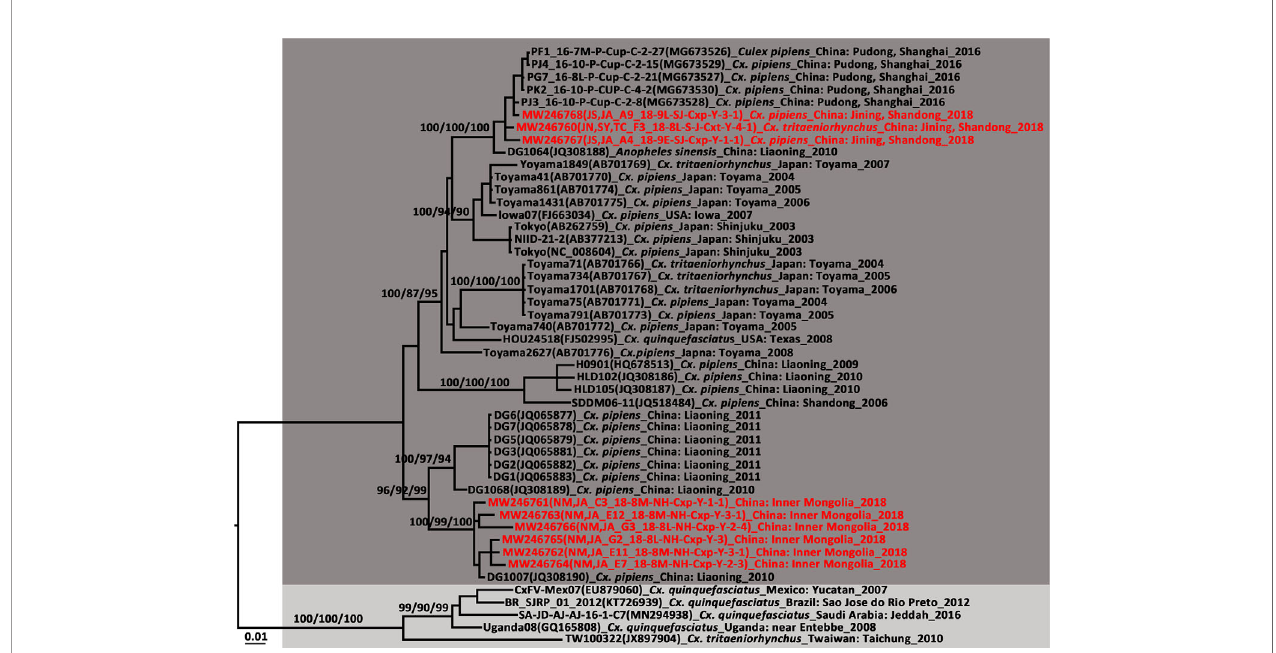
FIGURE 5 | Phylogenetic tree generated by Bayesian analysis of Culex fl avivirus (CxFV) complete genome. The virus strain, GenBank accession number, host, collection country and year are noted. The CxFV sequences obtained in this study are marked in red. Bootstrap values (1,000 replicates, not shown for less than 75%) of Bayesian analyses, maximum likelihood and neighbor-joining are shown above the main lineages. The scale-bar indicates 0.01 substitutions per site. Dark grey and light grey indicate CxFV Asian/USA genotype and Africa/Caribbean/Latin America genotype, respectively.